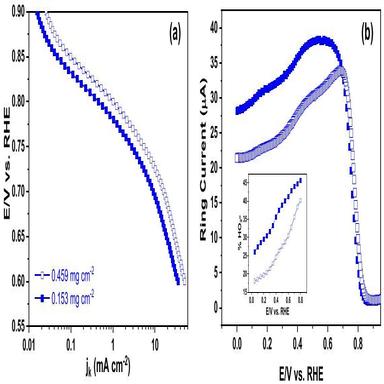
Tafel plots of the N-graphite with different catalyst loadings (a) and the corresponding ring current (b). The data were acquired in O2-saturated 0.10 M aqueous KOH at a potential scan rate of 2.00 mV s − 1 with 1600 rpm. The inset (b) shows the corresponding HO2 - %. jk is normalized with respect to the geometric surface area of the electrode.